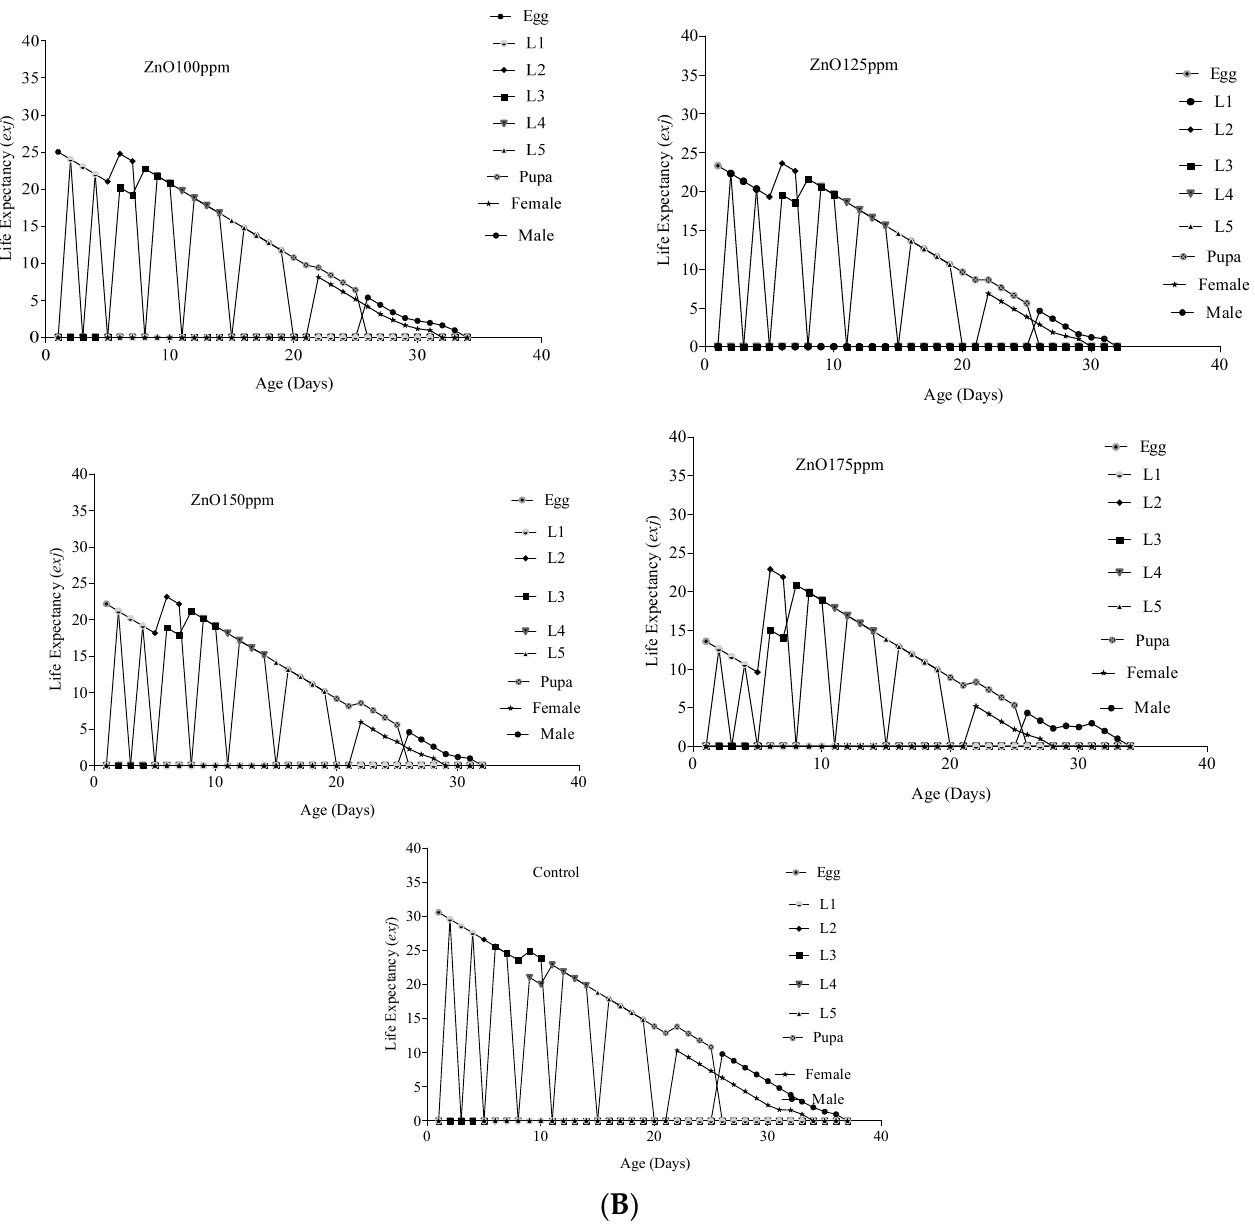
Figure 4. ( A ) Age-stage life expectancy ( e xj ) of 100, 125, 150,175 ppm and control of NPs treated H. armigera. ( B ) Age-stage life expectancy ( e xj ) of 100, 125, 150,175 ppm and control of NPs treated H. armigera.